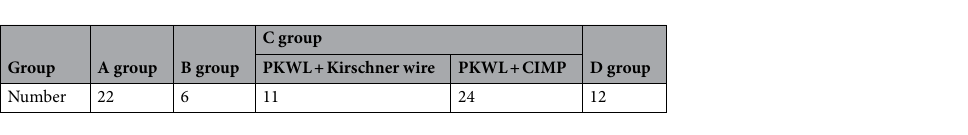
Table 1. Patient